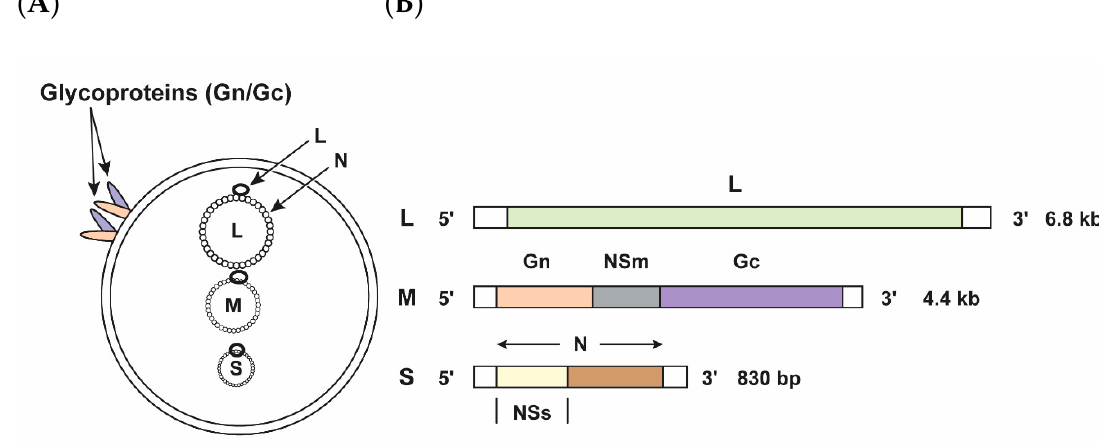
Figure 1. Schmallenberg virus (SBV) virion and genome organization. ( A ) The SBV large (L), medium (M), and small (S) segments are present in the virion and encapsulated with an envelope lipid bilayer containing the surface glycoproteins Gn and Gc. ( B ) Schematic representation of the SBV segments and the SBV coding strategy: L-segment: L, RNA-dependent RNA polymerase protein; M-segment: Gn and Gc, glycoproteins Gn and Gc; NSm, non-structural protein; S-segment: N, nucleoprotein; NSs, non-structural protein.